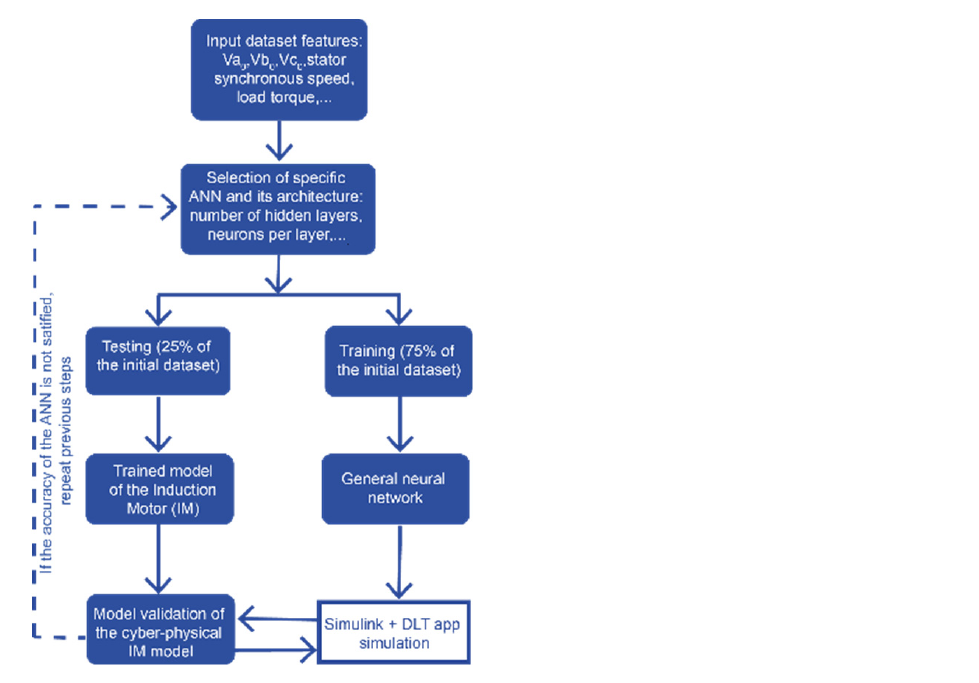
Figure 10. Diagram of the approach to deploy the general model of a cyber-physical system; there is only one neural network that learns from input data and outputs the next value.